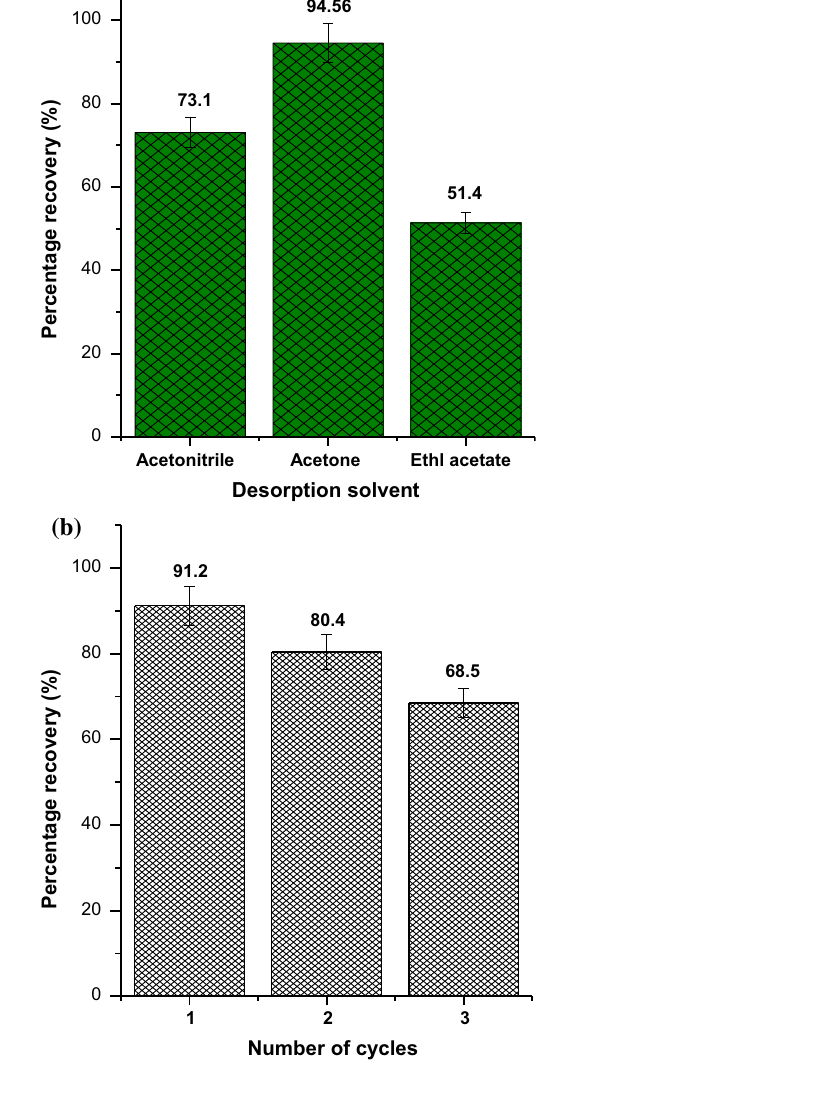
Fig. 16 a Desorption of deltamethrin by different solvents. b Reus- ability of the